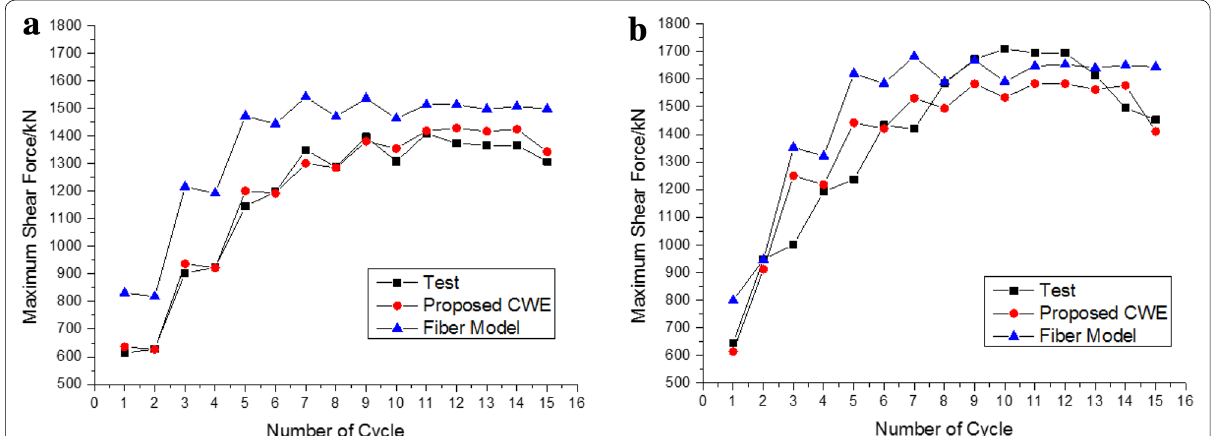
Fig. 17 Comparisons in maximum shear forces obtained from experimental data, proposed CWE model, and fiber model in each number of load cycle: a CW-1 and b CW-2.